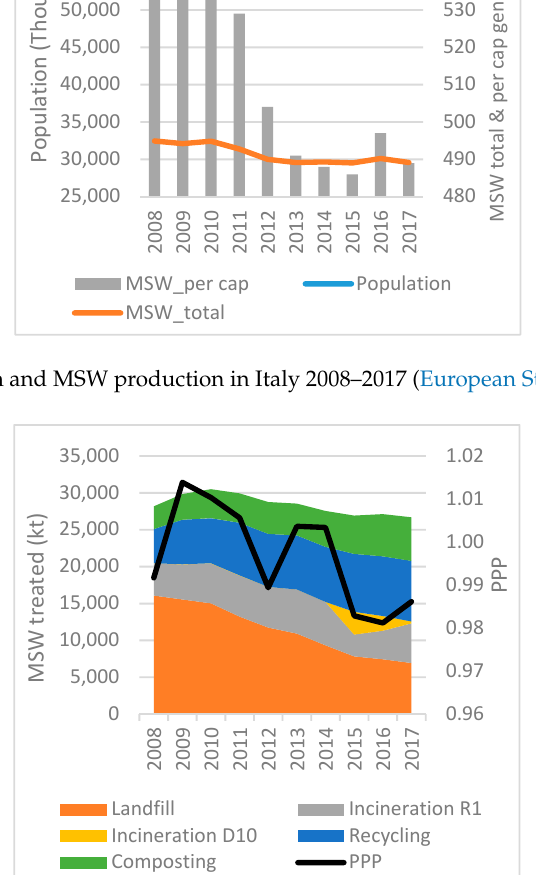
Figure 25. Population and MSW production in Cyprus 2008–2017 (EUROSTAT 2019a, 2019c).